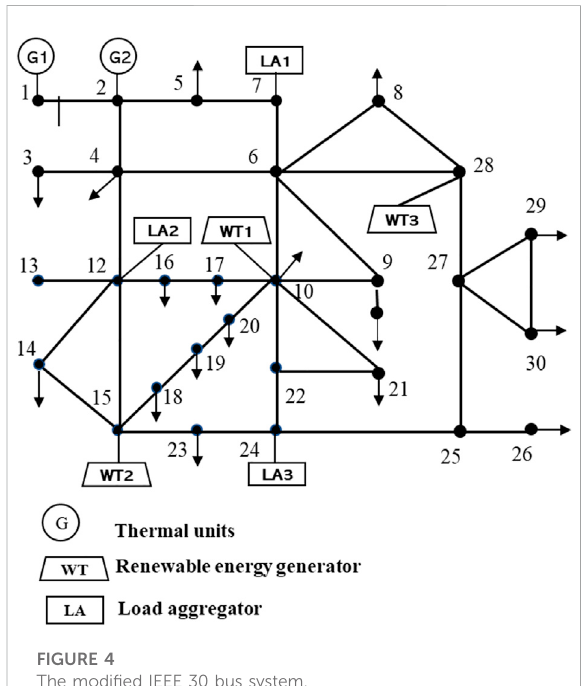
FIGURE 4 The modi fi ed IEEE 30 bus